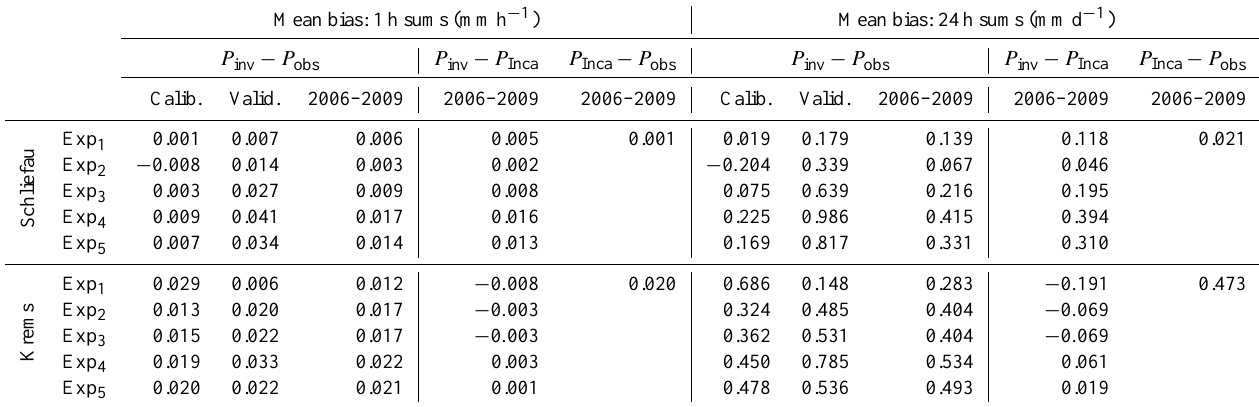
Table 9. Mean Bias (in mm) between different rainfall realisations, evaluated for different periods and 1h and 24h sums. Mean bias: 1h sums (mmh − 1